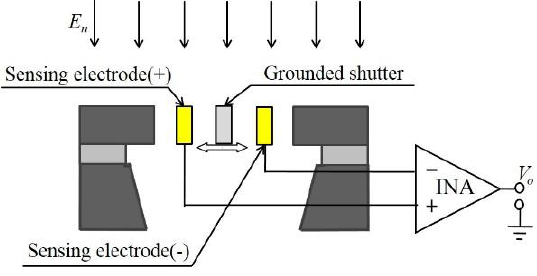
Figure 1. Operating principle of the resonant electric field microsensor (EFM) with coplanar electrodes.